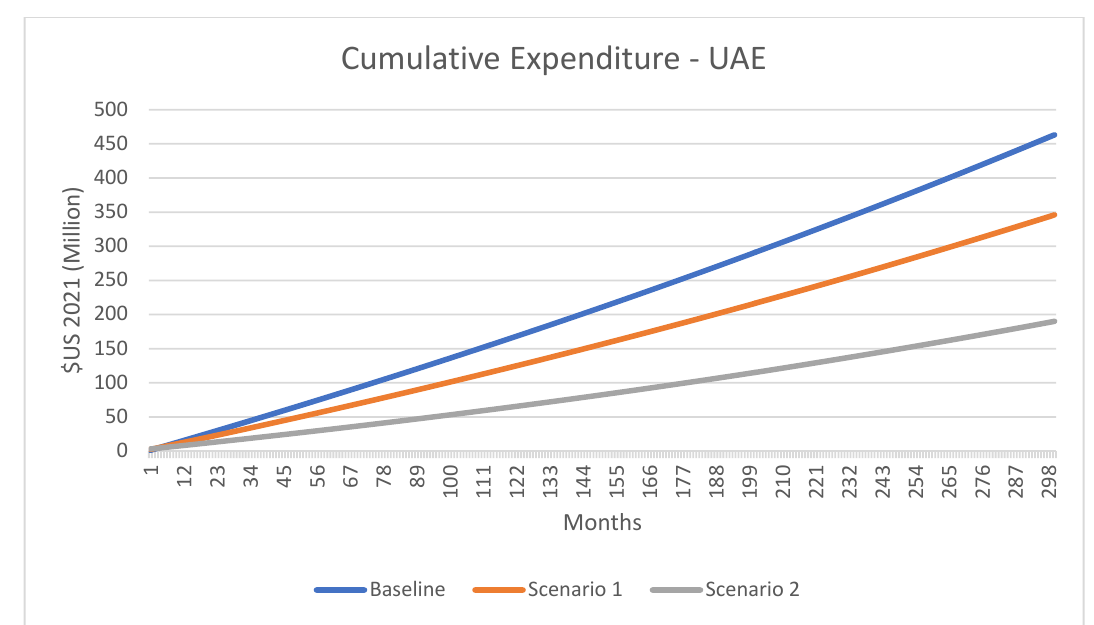
Figure 13. Comparison of emissions through electricity consumption under different scenarios in a reference cement plant in UAE.